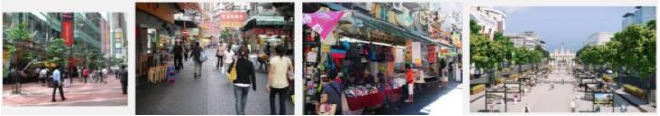
Figure 2. Full time pedestrian streets.